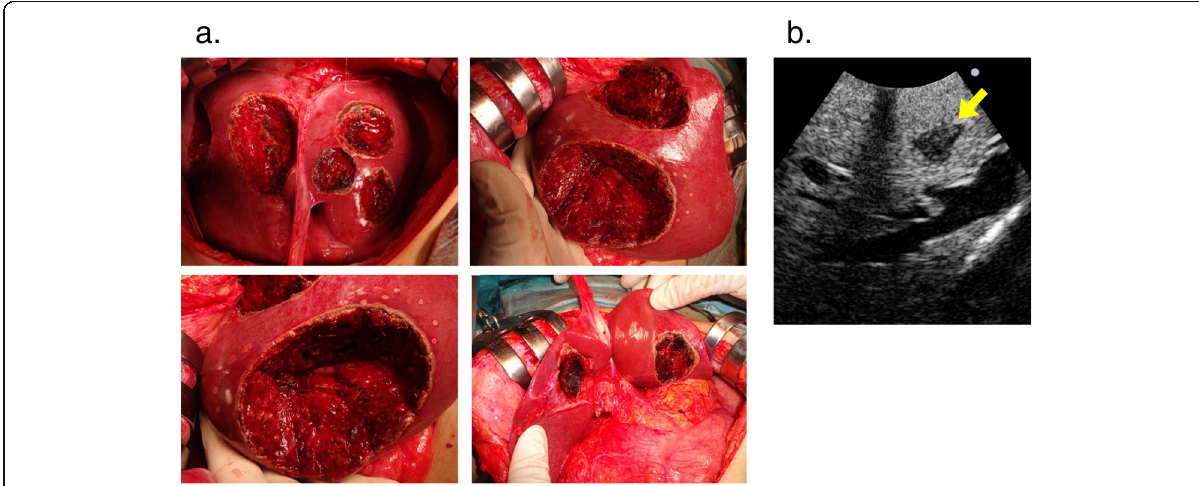
Fig. 3 Intraoperative images in CRLM resection. a Resection surface of the liver after a hepatectomy. b Contrast-enhanced ultrasonography using Sonazoid. Shrunken CRLM lesions were visualized as defects. CRLM, colorectal liver